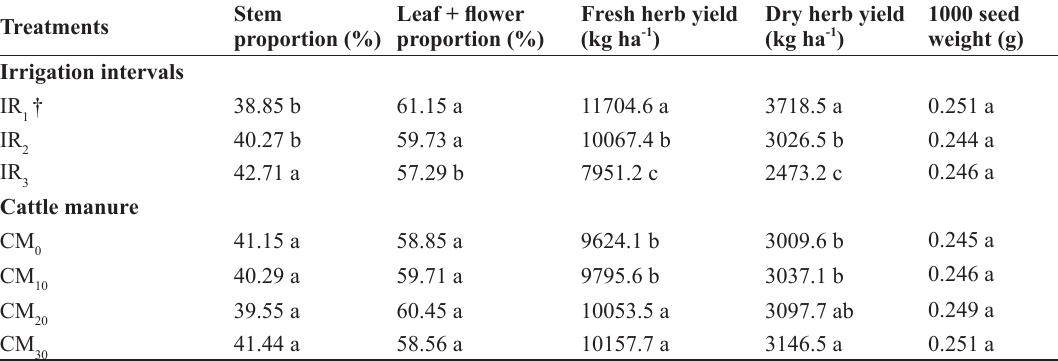
Effect of irrigation intervals, cattle manure levels and interaction of treatments on proportion of stem and leaf + flower, fresh and dry herb yield in oregano.